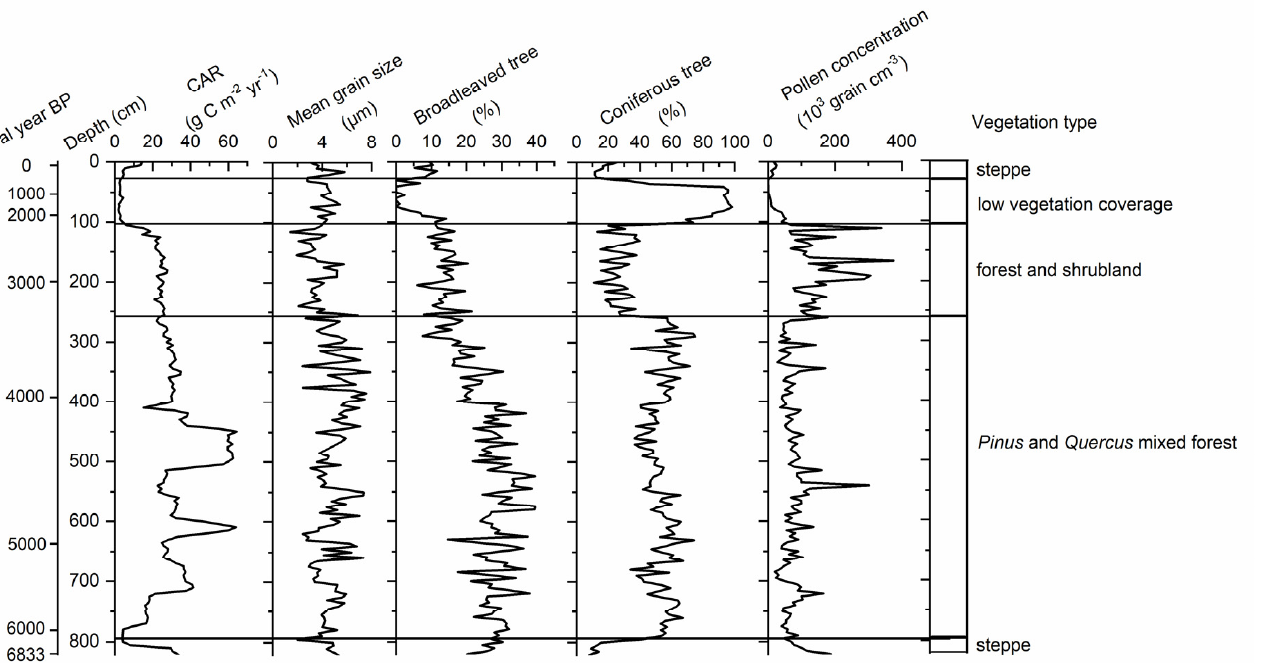
Figure 6. Temporal variation patterns of CAR according to vegetation change and the corresponding mean grain size (D (3, 2)), which were the most important factors by RDA and HP analysis. The vegetation change includes the broadleaved tree percentage, coniferous tree percentage, the pollen concentration and vegetation types.